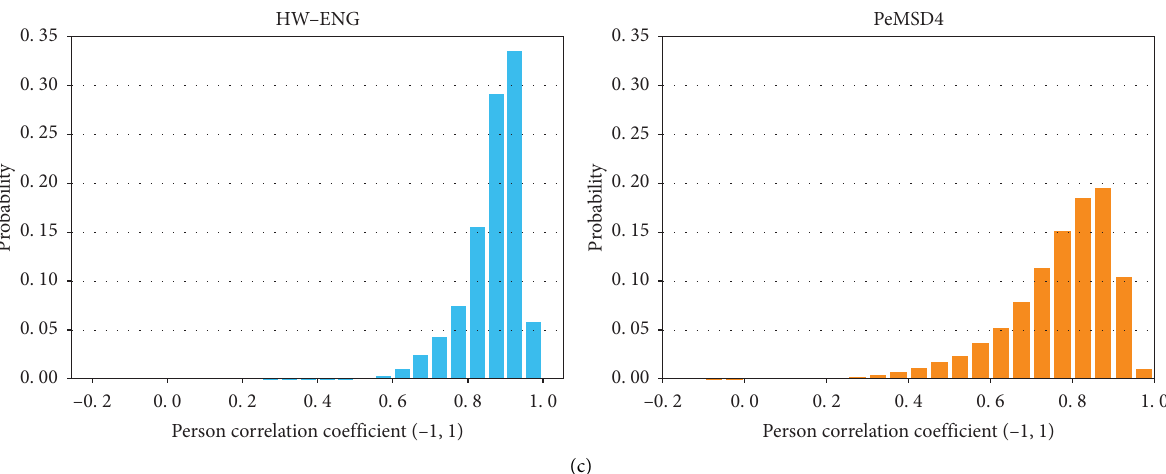
Figure 5: Distribution of trafc information in the PEMSD4 and HW-ENG datasets: (a) distribution of speed data; (b) distribution of trafc fow data; (c) distribution of correlations between nodes in the trafc